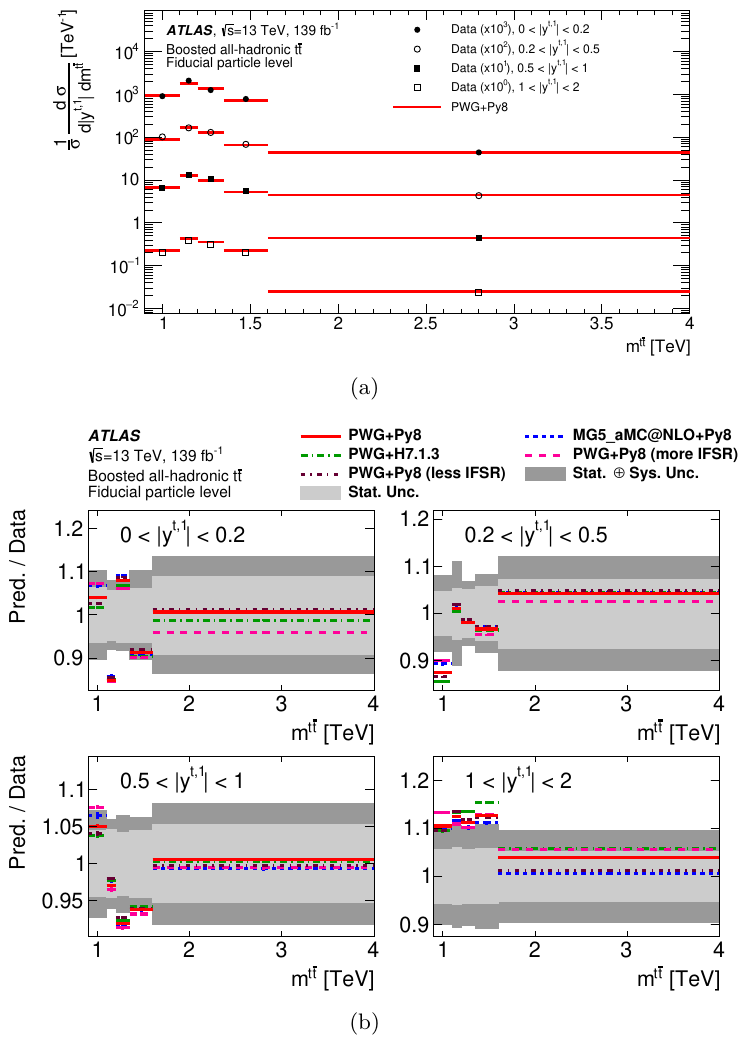
Figure 42 . (a) Normalized particle-level fiducial phase-space double-differential cross-sections as a function of the absolute value of the rapidity of the leading top-quark jet and the mass of the t ¯ t final state, compared with the Powheg+Pythia 8 calculation. Data points are placed at the centre of each bin and the Powheg+Pythia 8 calculation is indicated by solid lines. The measurement and the prediction are normalized by the factors shown in parentheses to aid visibility. (b) The ratios of various MC calculations to the normalized particle-level fiducial phase-space differential cross-sections. The dark and light grey bands indicate the total uncertainty and the statistical uncertainty, respectively, of the data in each